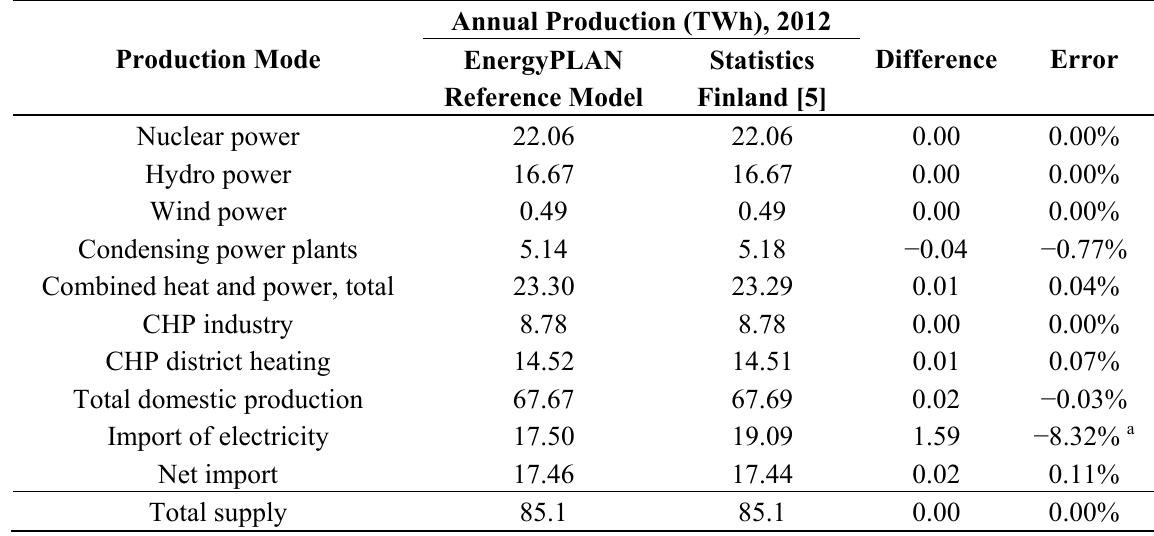
Table 2. Comparison of the results from EnergyPLAN model and the recorded data for Finland